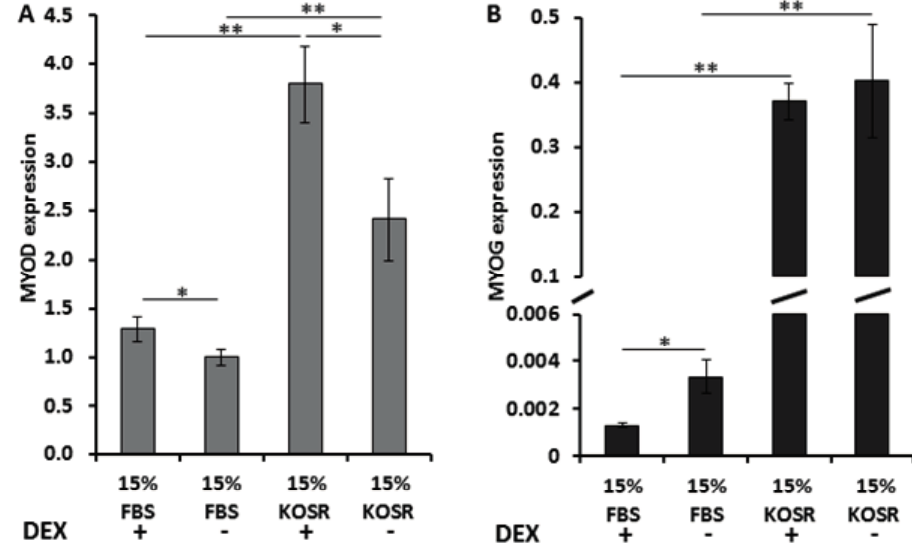
Figure 4. KOSR and dexamethasone affect MYOD and MYOG expressions in immortalized FSHD myoblasts. Expression level of MYOD ( A ) and MYOG ( B ) were affected differently by KOSR and dexamethasone. DEX, dexamethasone; FBS, fetal bovine serum; KOSR, knockout serum replacement; “*”: p < 0.05; “**”: p <